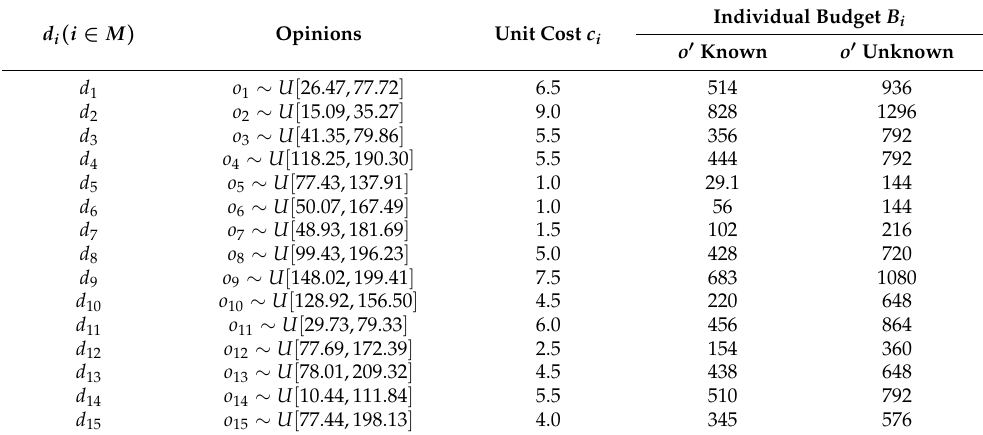
Table 2. Data of 15 decision resident groups in urban demolition